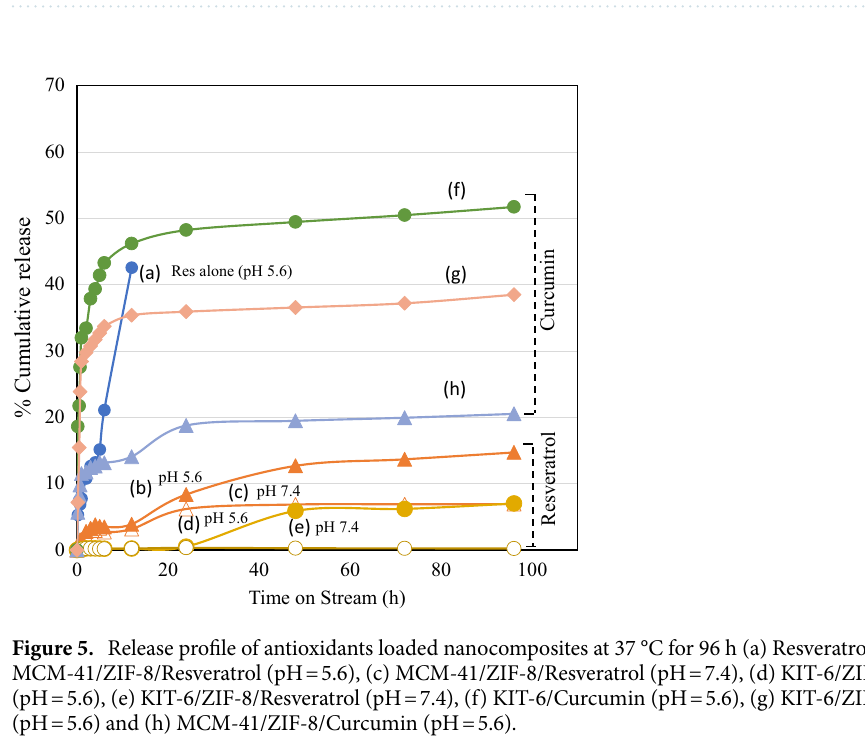
Figure 4. Diffuse reflectance spectra of (a) KIT-6/ZIF-8, (b) Resveratrol, (c) Curcumin, (d) MCM-41/ZIF-8/ Curcumin, (e) KIT-6/ZIF-8/Curcumin, (f) MCM-41/ZIF-8/Resveratrol and (g) KIT-6/ZIF-8/Resveratrol nanocomposites.